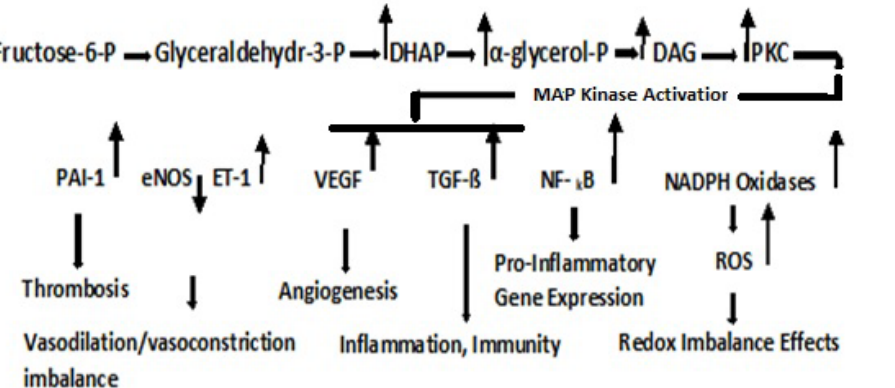
Figure 6. PKC Pathway and Pathogenic Effects. DHAP , dihydroxyacetone phosphate; DAG , diacyl- glycerol [41]; PKC , Protein Kinase C. Diagram depicts effects of isoforms ß and ð, which are both activated by DAG. The upregulation of PAI-1 , Plasminogen activator inhibitor-1 (serpin E1), is a risk factor for thrombosis and atherosclerosis [40]; the downregulation of eNOS , Endothelial nitric oxide synthase, leads to vasodilation and upregulation of ET-1 , Endothelin-1, a vasoconstrictor [42]; upregulation of VEGF, Vascular endothelial growth factor (a glycoprotein), mediating retinopathy and nephropathy [43]; TGF-ß, Transforming growth factor-beta (a multifunctional cytokine) that is pro-inflammatory and affects host immunity [44]; NF-kß, Nuclear factor-kappa B, a DNA binding protein factor required for the transcription of pro-inflammatory gene expression [45]; NADPH Oxidase , nicotinamide adenine dinucleotide phosphate oxidase (a flavocytochrome B heterodimer), a major source of ROS [46].